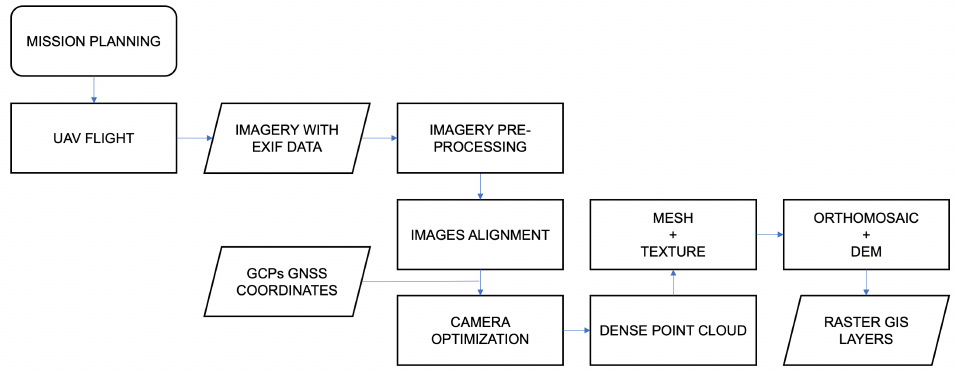
Figure 5. Flowchart representing the complete UAV workflow. The first two steps specifically developed for this work are described in Section 4.2 and detailed in the checklist in Appendix A. The next steps implement SfM